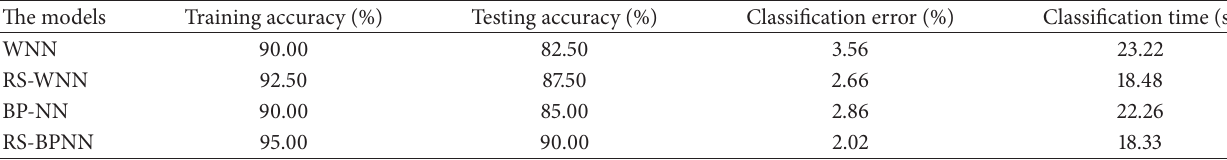
Table 5: Classification performance of the four models of neural networks.